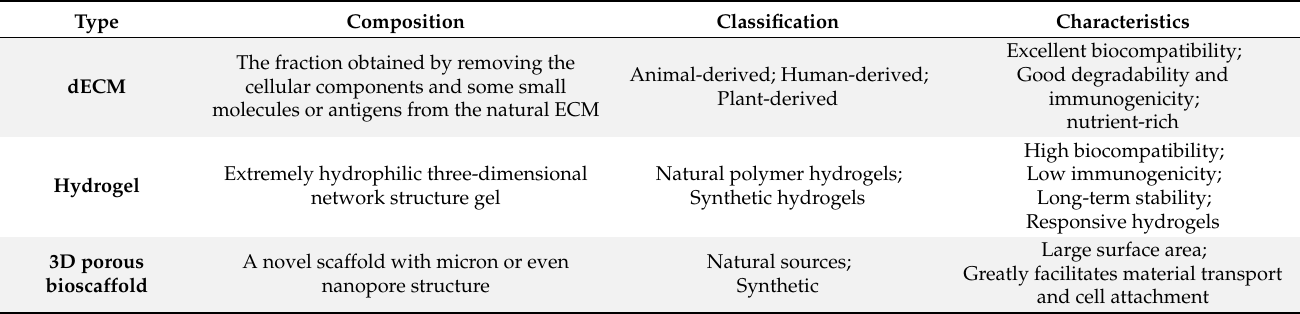
Table 2. Comparison of currently common 3D bioprinting